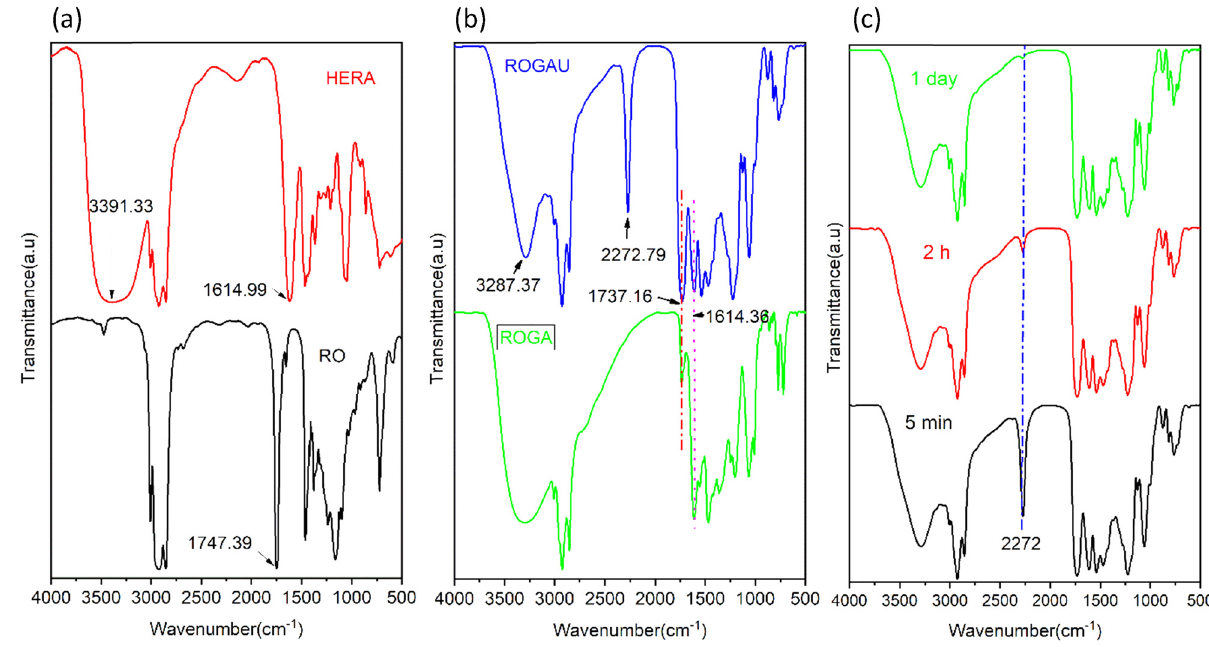
Figure 1: FTIR spectra of: ( a ) RO and HERA, ( b ) ROGA and ROGAU, and ( c ) Curing of